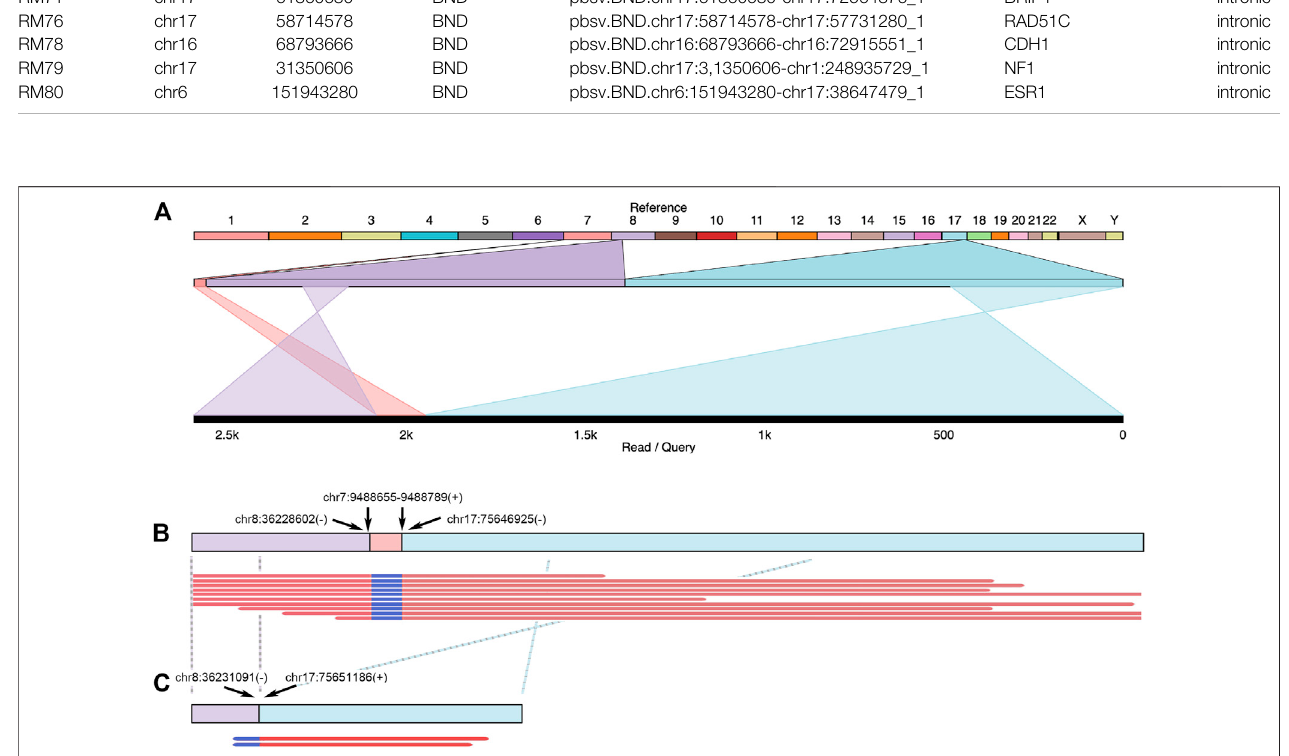
FIGURE 7 | Example of fusion genes and transcripts observed in patient tumor tissues. In Patient RM64, several structural variants (including DEL and BND) were identi fi ed at FANCC, RAD50, and RECQL5 regions. A three-segment fusion gene observed at RECQL5 was illustrated. (A) Top line: reference genome from hg38. Numbers and letters indicated individual chromosomes. Middle line: expansion of sequenced regions from chromosomes 7, 8, and 17. Bottom line: Illustration of one genomic structure in RM64T samples, containing regions from chromosomes 8, 7, and 17. Crossed projection lines from middle to bottom lines represented reversions occurred during the fusion process. (B) Top line: a plot of this fusion gene at genomic DNA. Breakpoint notation locations were labeled by arrows. Plus and minus symbols showed forward and reverse directions, respectively. Bottom lines: representative data selected from individual reads. (C) Transcripts observed in this area. Top line: a cartoon demonstration of corresponding mRNA. Crossed dash lines showed a reversion observed after a comparison to reference. Bottom lines: two reads continuously from chr8 to chr17 were shown. The chr7 segment in this fusion gene did not have detectable mRNA reads.